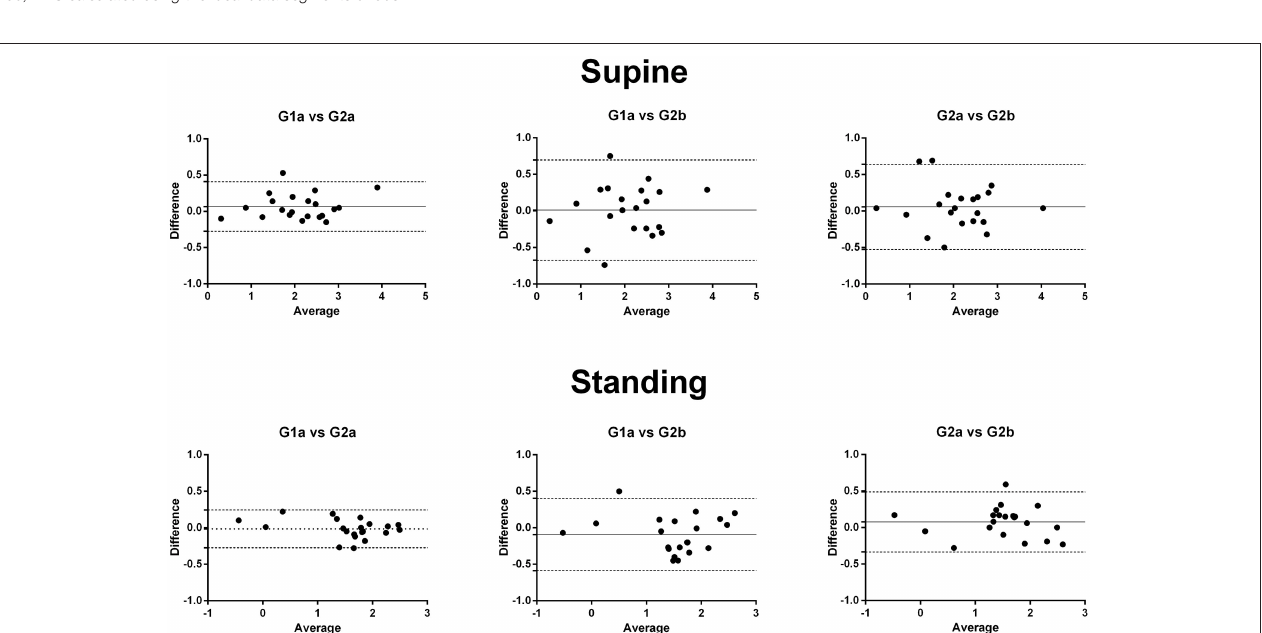
FIGURE 3 | The Bland-Altman plot of the differences and means of the logarithmic transformed BRS-values using different global data segments. There was no significant fixed or proportional bias. G1a, BRS calculated using the global data segment 1a; G2a, BRS calculated using the global data segment 2a; G2b, BRS calculated using the global data segment